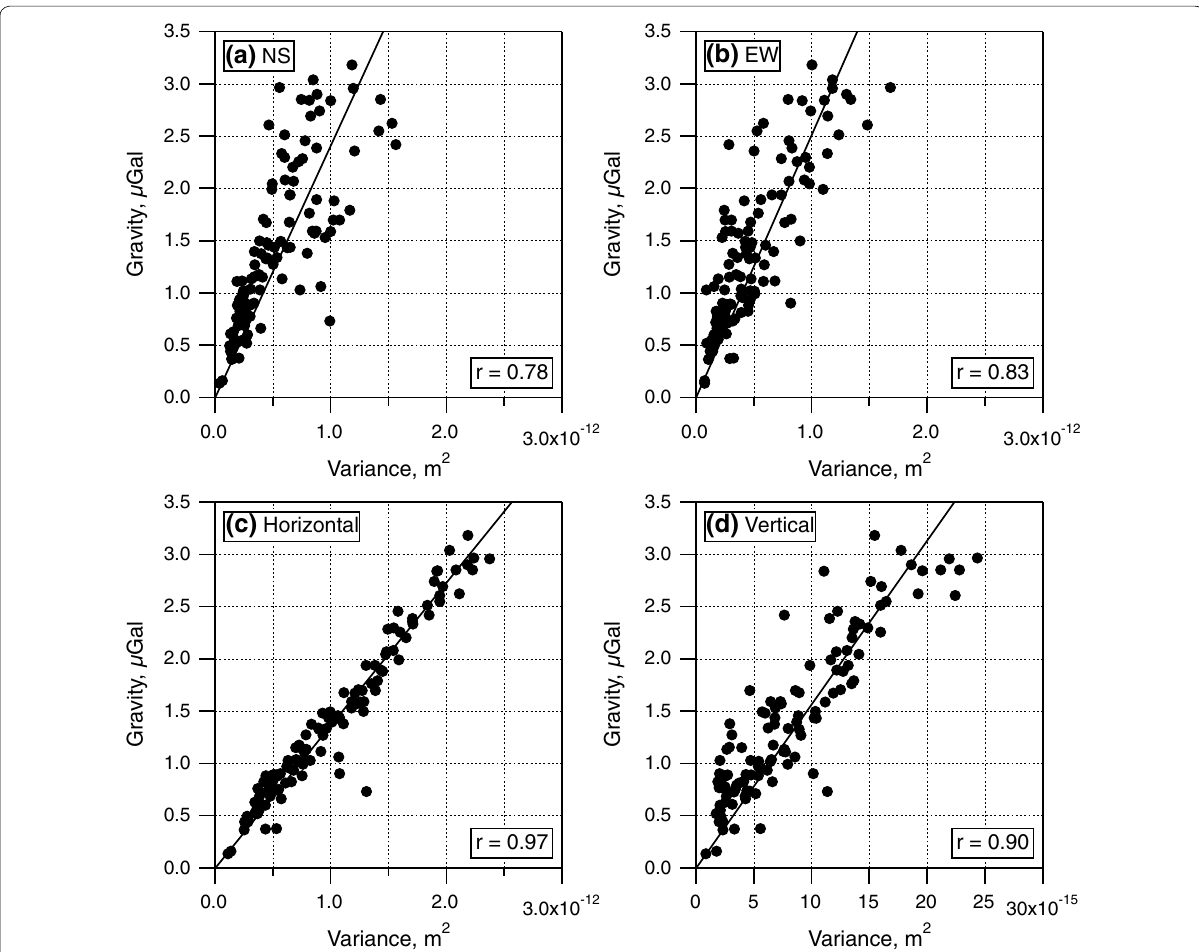
Fig. 7 Relationship between the ground displacements and gravity changes. The four panels represent the a north–south component, b east– west component, c horizontal component and d vertical component. The ground displacements are shown in terms of variances in time domain. Straight lines are the results of linear regression for the data, and the linear correlation coefficients are also shown. Note that the horizontal scale in d is different from those in the other